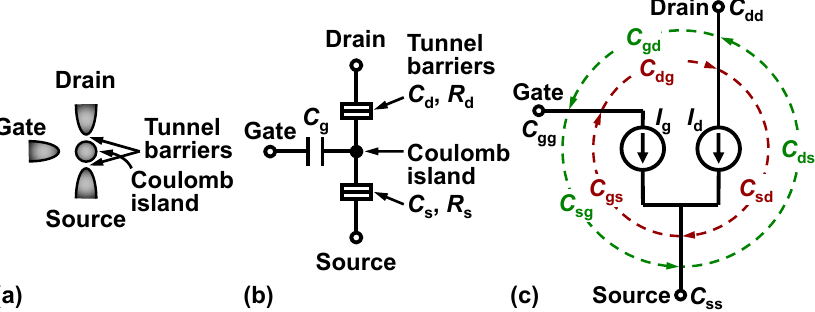
Figure 1. ( a ) SET pictorial schematic, ( b ) symbolic schematic, and ( c ) model schematic with capaci- tance components inside the SET.